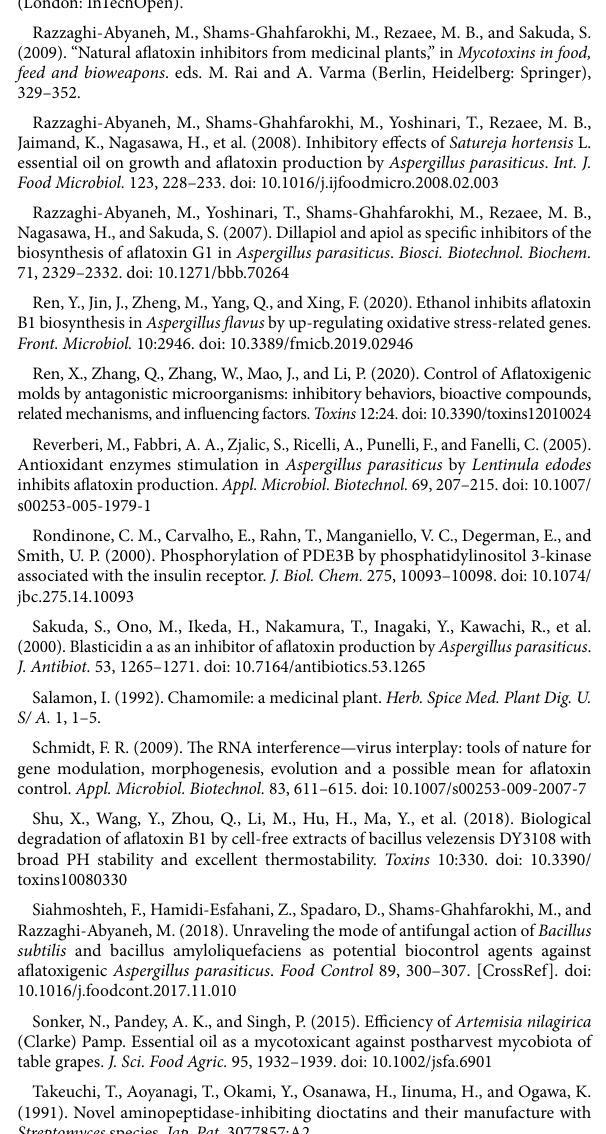
table grapes. J. Sci. Food Agric. 95, 1932–1939. doi: 10.1002/jsfa.6901 Takeuchi, T., Aoyanagi, T., Okami, Y., Osanawa, H., Iinuma, H., and Ogawa, K. (1991). Novel aminopeptidase-inhibiting dioctatins and their manufacture with Streptomyces species. Jap. Pat.